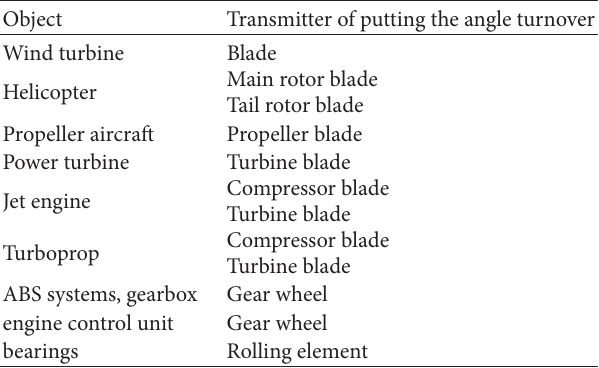
Table 3: Potential field of tip timing method